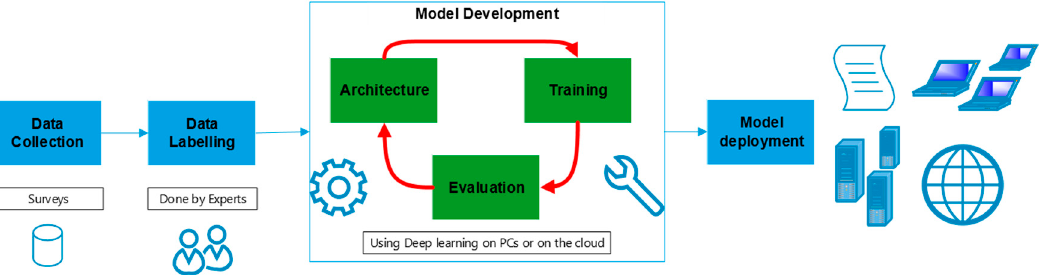
Figure 2. Typical model development setup.